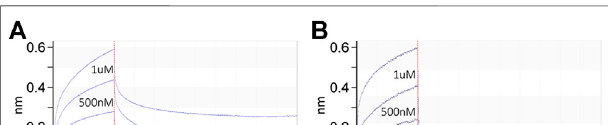
Frontiers in Molecular Biosciences |